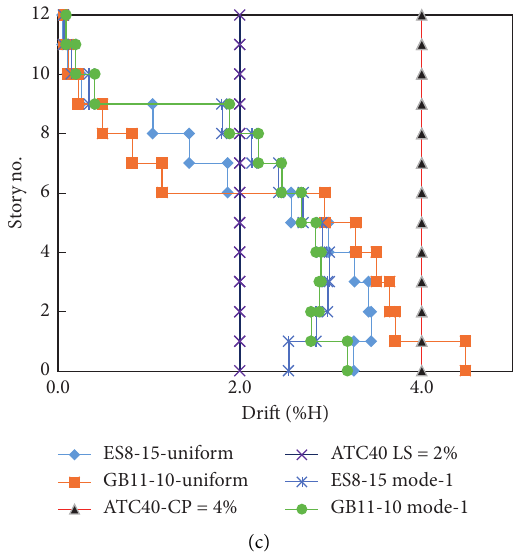
Figure 11: Interstory drift: (a) 4-story, (b) 8-story, and (c) 12-story